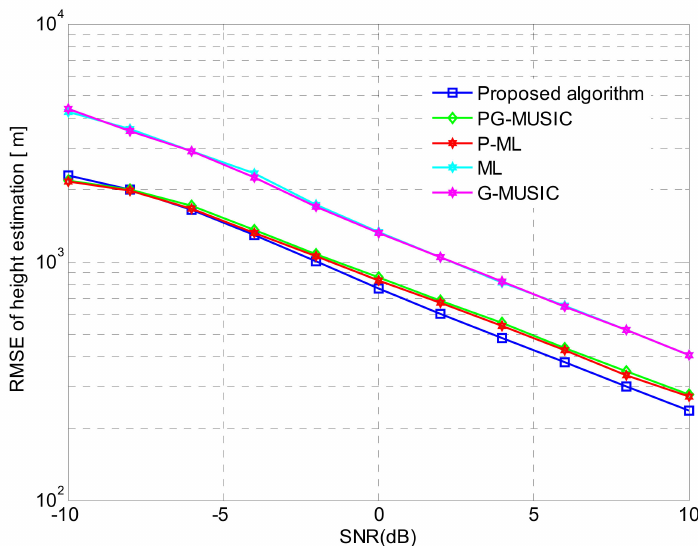
Figure 4. RMSE of height measurement versus SNR.